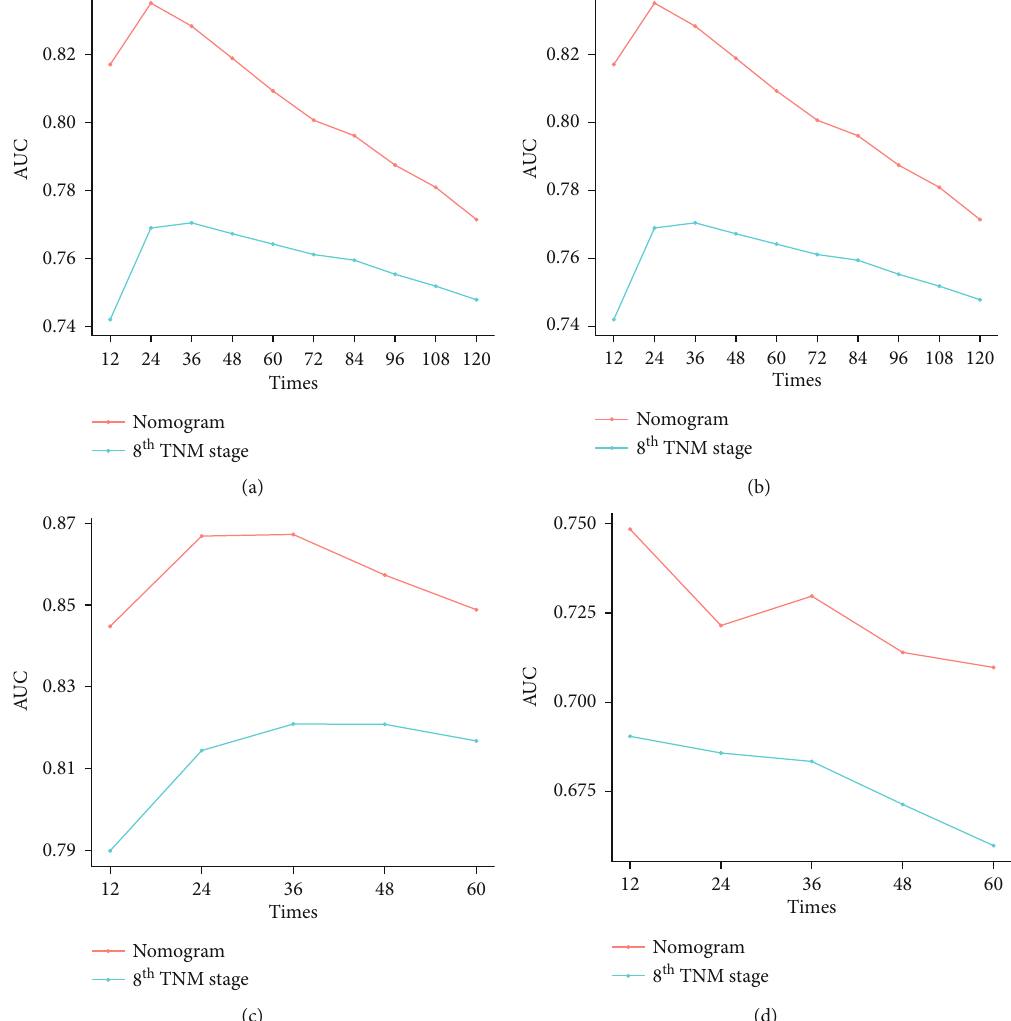
Figure 3: AUC of the nomogram and 8 th TNM staging in the prediction of prognosis of patients from the 1-year to the 10-year point in the development cohort (a), development cohort with bootstrapped validation (b), validation cohort (c), and test cohort (d). AUC: areas under the receiver operating characteristic Figure 4), validation cohort (1-year: 0.047 vs. 0.051, 2-year: 0.077 vs. 0.084, 3-year: 0.097 vs. 0.104, 4-year: 0.113 vs. 0.119, and 5-year: 0.123 vs. 0.128, respectively, P < 0 : 05 ; Figure 4), and test cohort (1-year: 0.064 vs. 0.065, 2-year: 0.134 vs. 0.147, 3-year: 0.170 vs. 0.192, 4-year: 0.188 vs. 0.205, and 5-year: 0.202 vs. 0.226, respectively, P < 0 : 05 ; Figure 4).